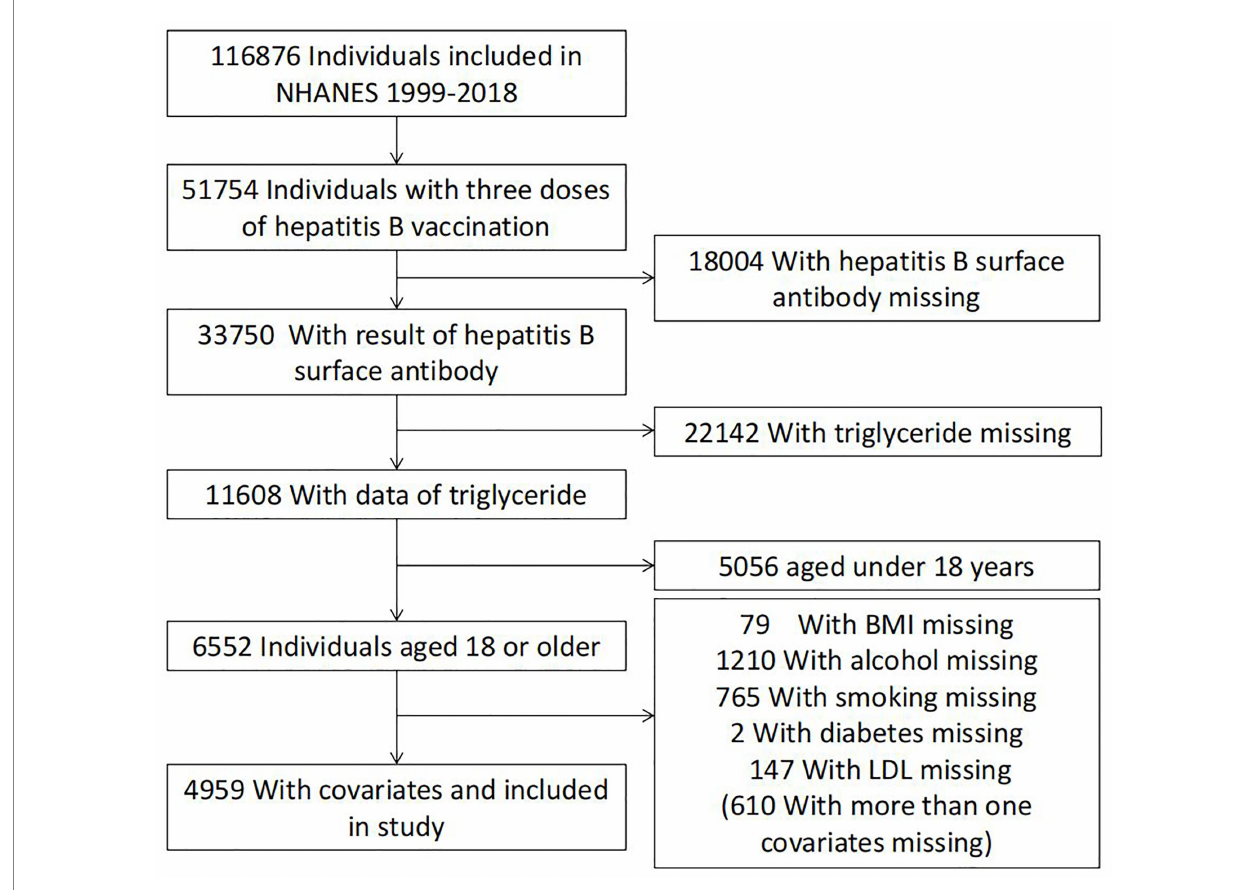
FIGURE 1 Flow chart of the population included in the final analysis of our